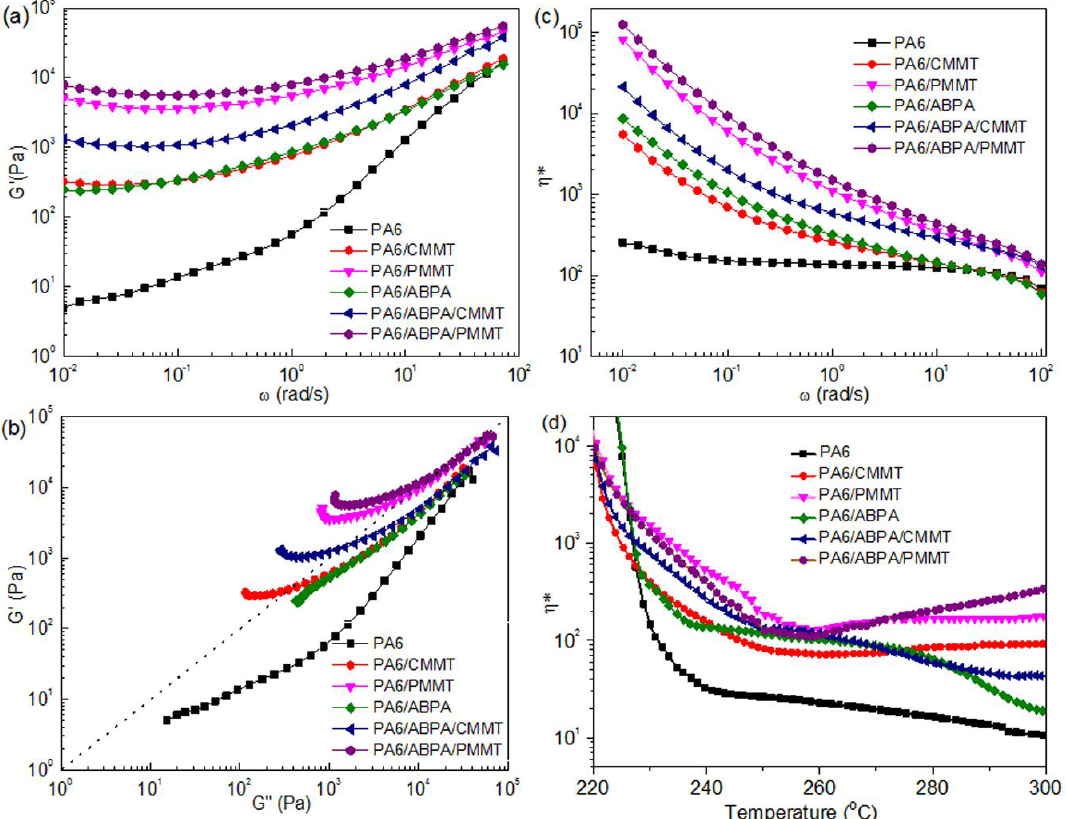
Figure 4. Storage modulus ( a ); melt viscosity ( b ) and Han polt ( c ) versus frequency at 230 °C , and melt